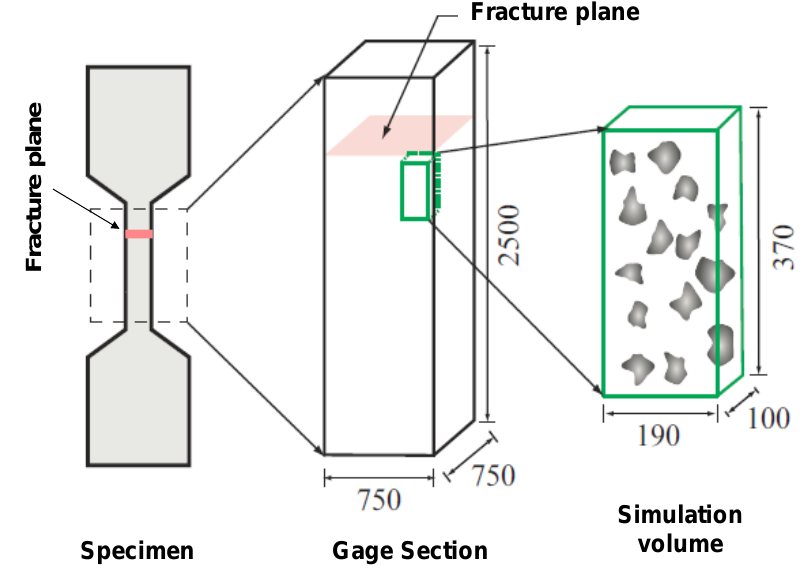
Figure 1. Location of the simulation domain relative to the gage section and fracture plane in the experimental specimen. All dimensions are in µm.